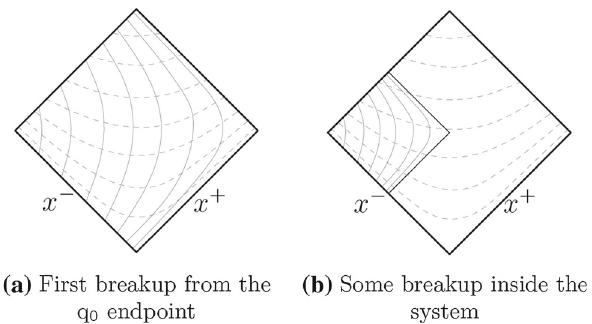
Fig. 4 Hyperbolae of constant Γ and m 2 full lines,